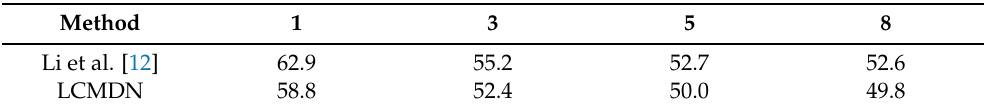
Table 4. Comparison between different numbers of kernels. Numbers in the first row represent the number of kernels.